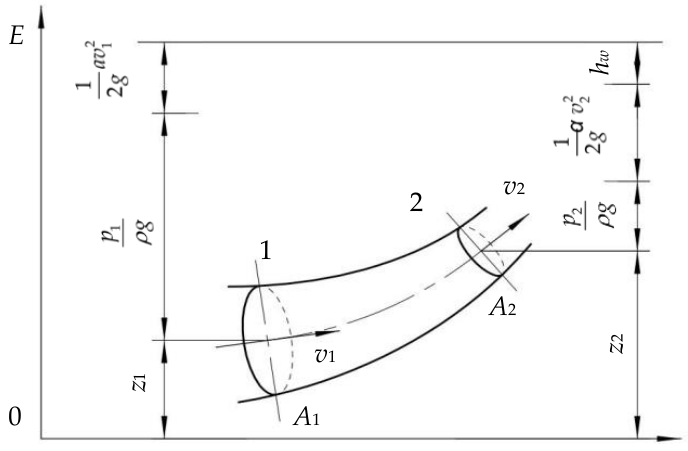
Figure 3. Schematic diagram of the one-dimensional flow energy Equation.